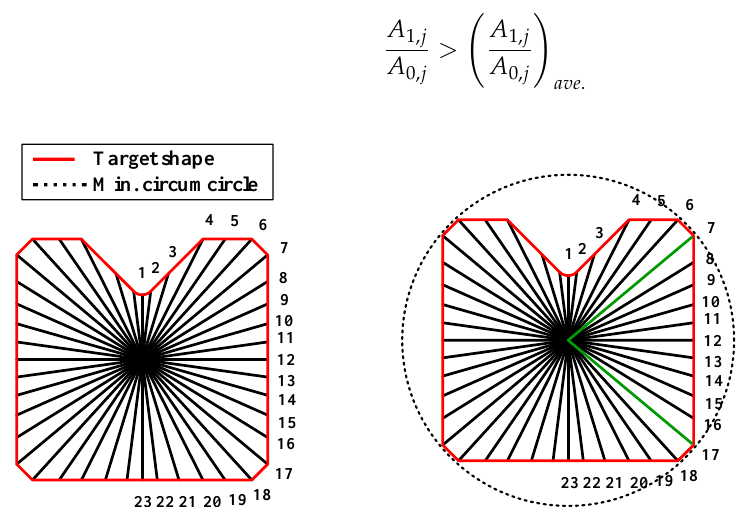
Figure 4. Radius from the center to the target shape of the cross-roller guide.